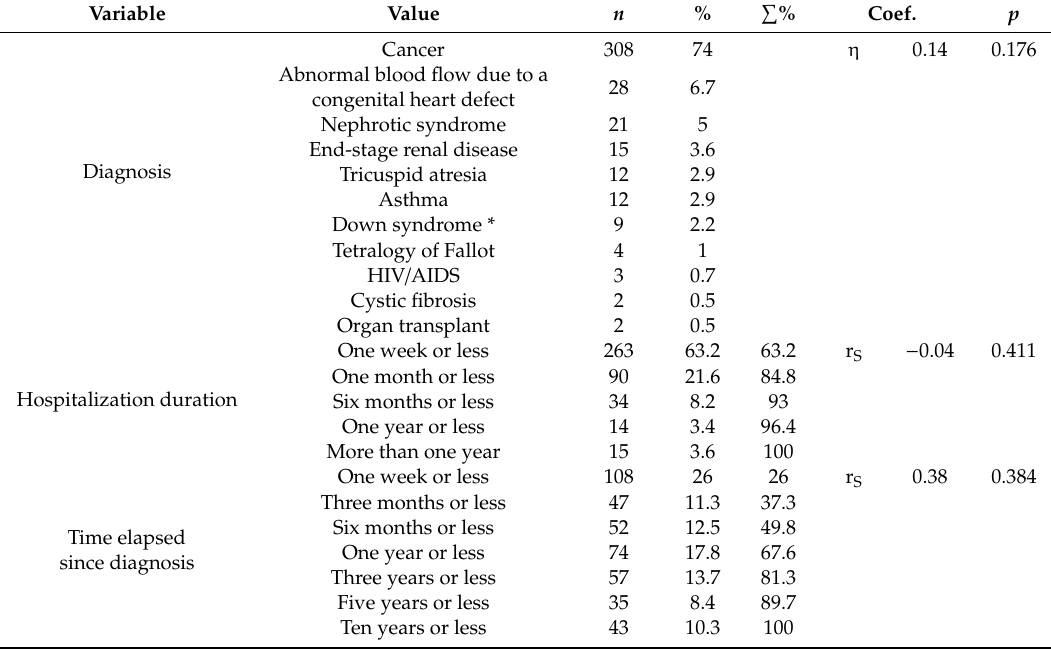
Table 3. Frequencies and percentages of the pediatric patients’ clinical variables and their association with parents’ QOL total